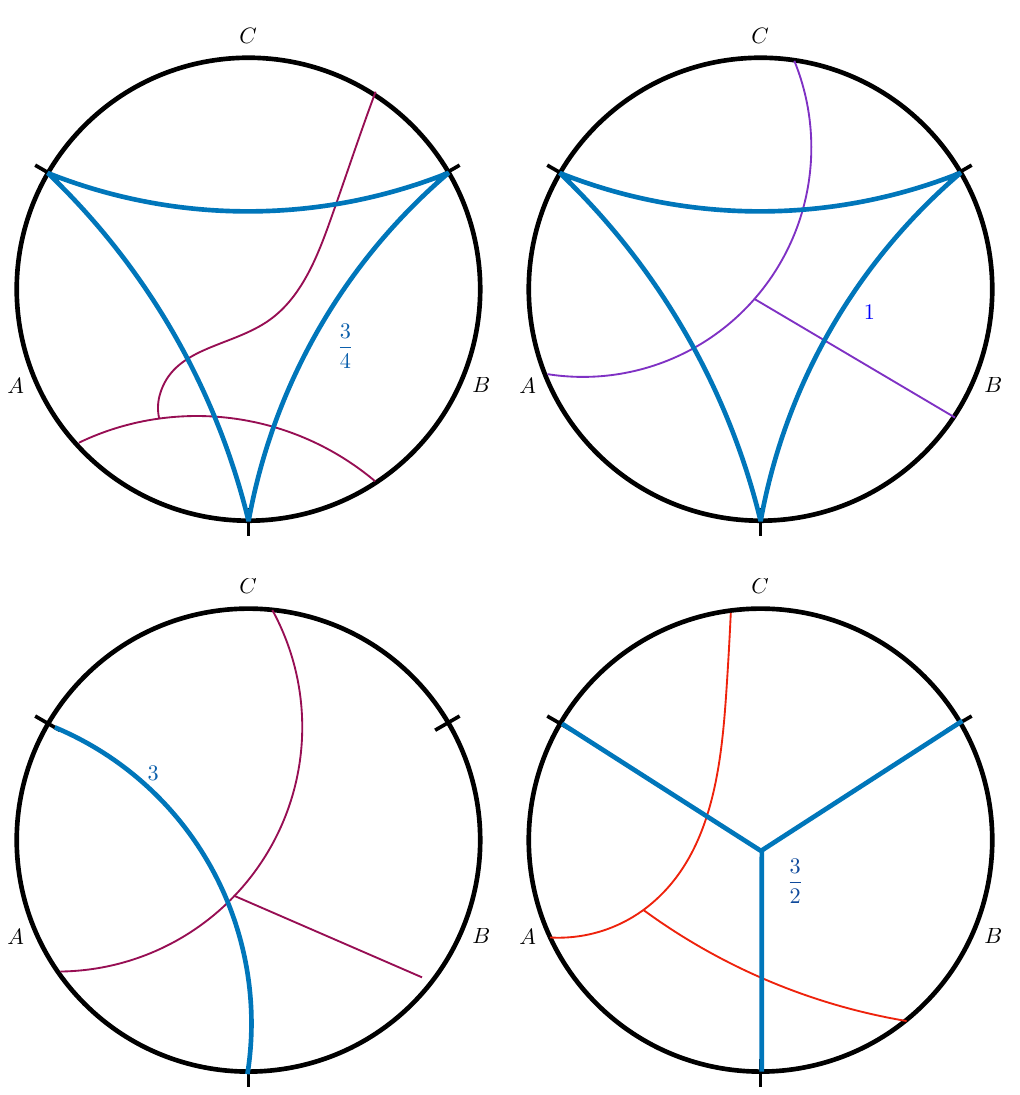
Figure 6 . A number of possible barrier configurations for the program (3.17) for three regions of AdS . Shown in each is an example of a 3-thread which could contribute to the objective. 3 TL: the configuration is not feasible as a 3-thread splitting in the interior region would cross a barrier of 9 < 3 . TR: the proposed configuration is given by m 2 however (3.16) proved 3 -threads 4 cannot saturate this surface. BL: placing the barrier on the smallest RT surface is feasible, but is large due to the contribution from the uv cutoff at the boundary. BR: the true minimal surface m 3 . The introduction of a bulk intersection point substantially reduces contribution coming from the